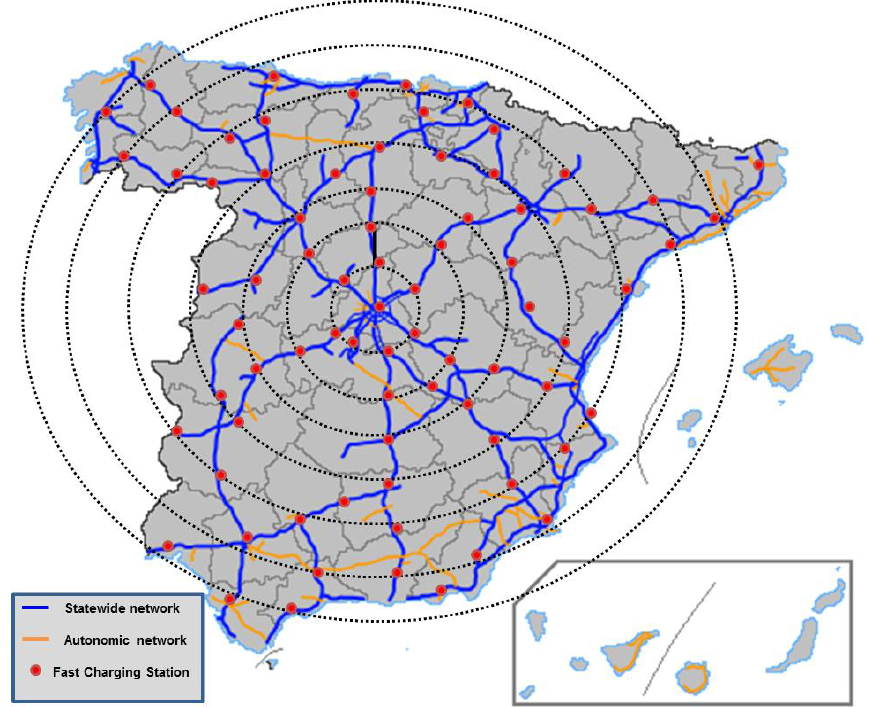
Figure 9. State highway network and MDFC range, radial topology